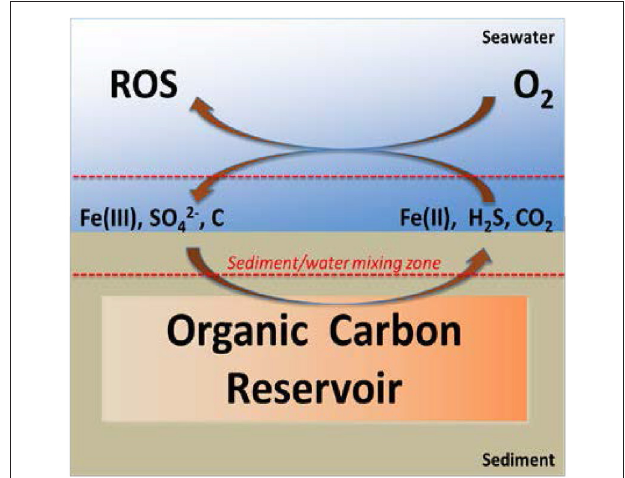
FIGURE 1 | Microbial oxidation of buried carbon results in the production of Fe(II), HS − , and ROS. Anaerobic microbial respiration is often based on the use of Fe(III) or SO 2 − 4 as electron acceptors. When resulting Fe(II) and HS − in porewater (present as ions or FeS) mix with the oxic portion of the water column their abiotic oxidation leads to the formation of ROS along with the regeneration of Fe(III) and SO 2 − 4